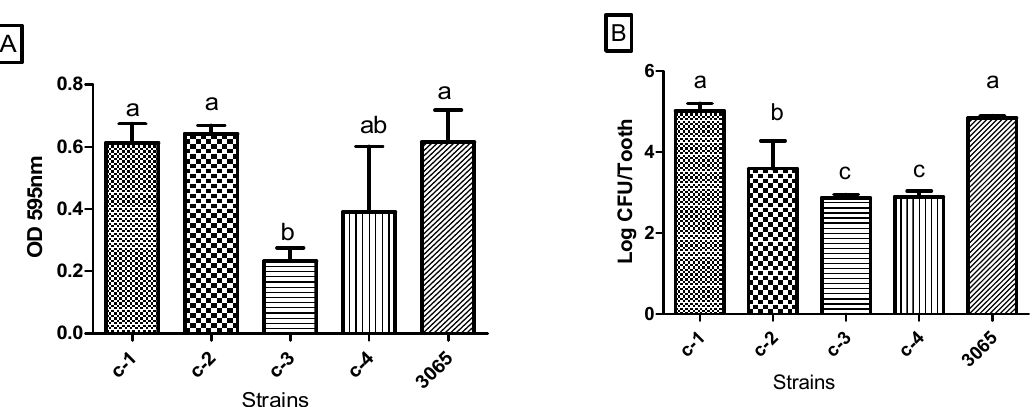
Figure 4. Biofilm formation of four isolated strains and one reference strain. Biofilms were formed on the surface of resin dentures and quantified through crystal violet assay ( A ) and cell enumeration ( B ) 3065: S. mutans KCTC 3065 C-1: Streptococcus salivarius ; C-2: Streptococcus anginosus ; C-3: Leuconostoc mesenteroides ; C-4: Lactobacillus sakei . Vertical bars represent standard error of the mean ( n = 3), different letters in the same group indicate a significant ( p < 0.05) treatment effect.